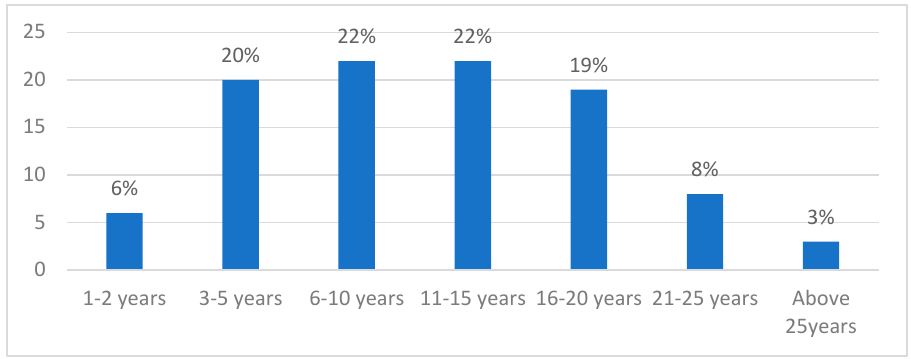
Figure 2. Respondents’ years of experience.